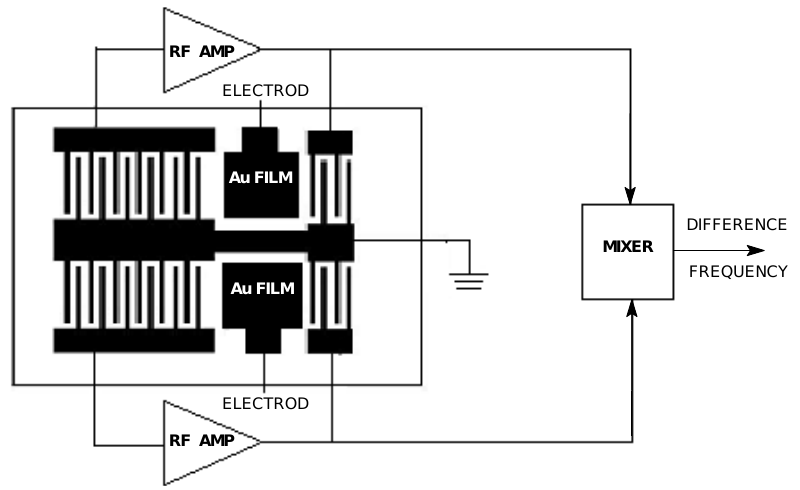
Figure 1. Schematic and principle of a SAW